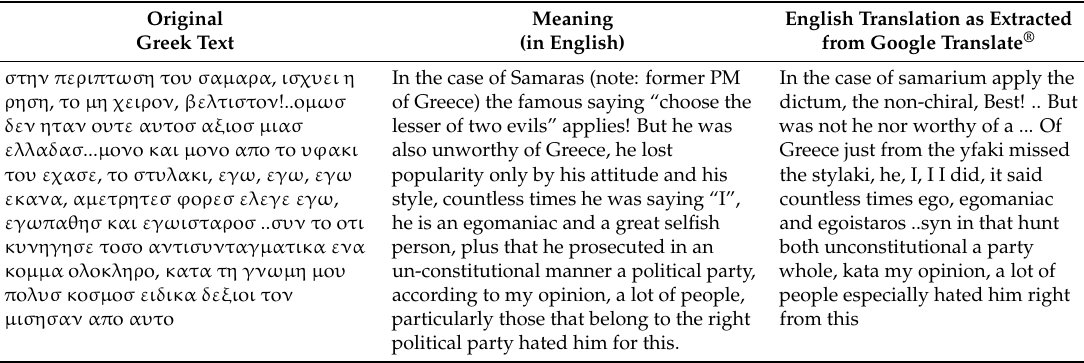
Table 1. Dealing with machine translation at the sentence level on a real example from our